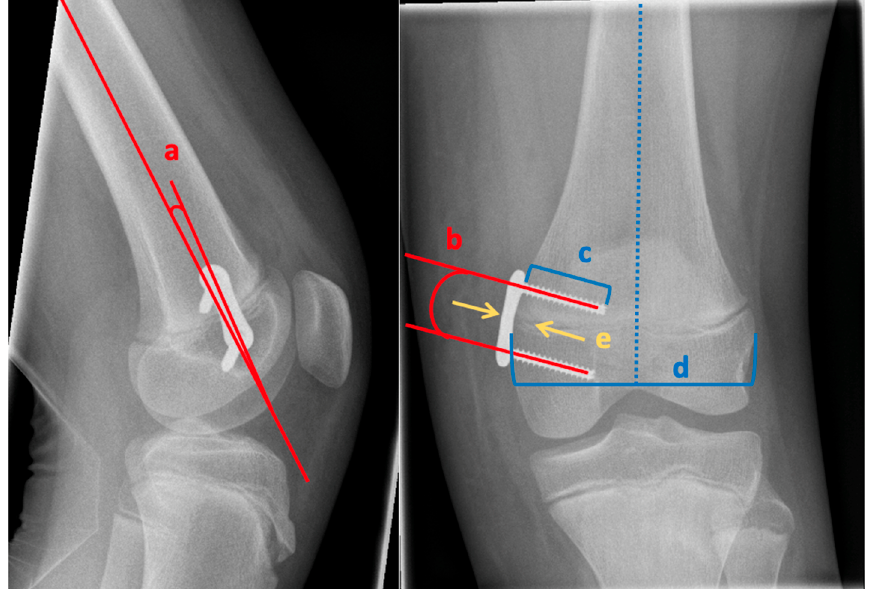
Figure 2. Radiological assessment: a—angle between the implant and femur axis, b—angle between the two screws, c—length of the screw, d—width of the epiphysis (greatest width of the epiphysis perpendicular to the axis of the femur), e—relation of the center of the plate to the physis (left arrow pointing at the center of the plate and right arrow pointing at the center of the physis).